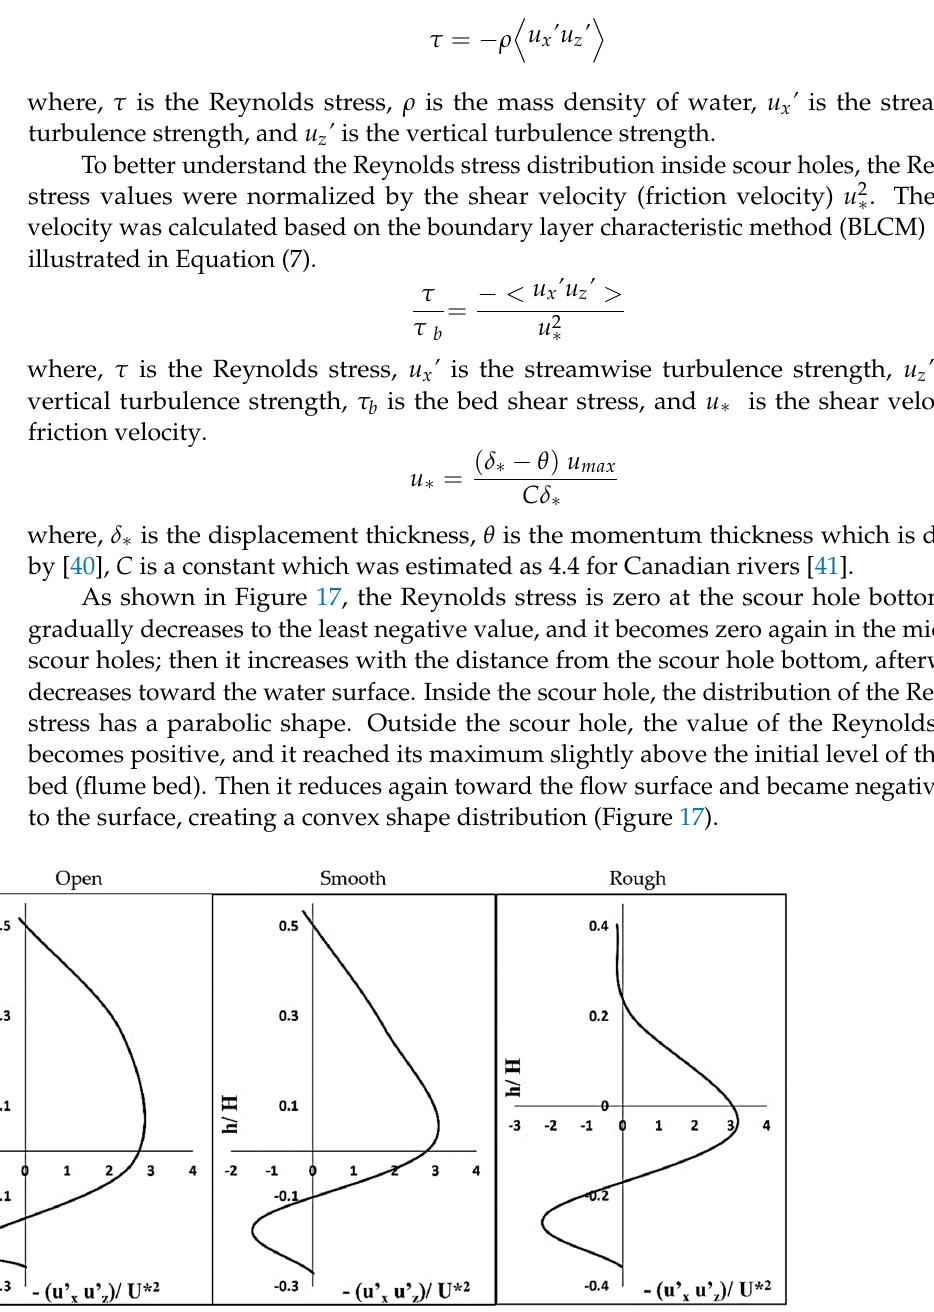
Figure 16. Turbulence intensity in three directions under different surface cover conditions with the dike orientation of 90° (water depth: 35 cm). ADV measurements subject to +/- 0.25 cm/s error.